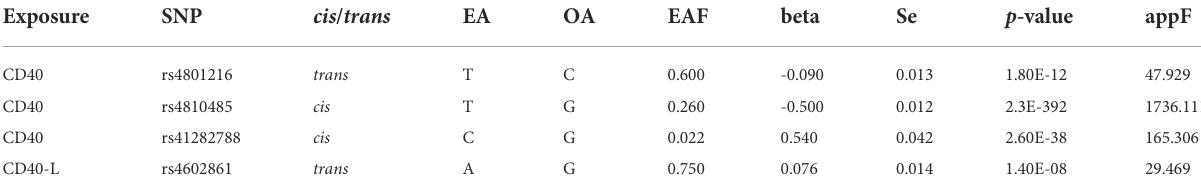
TABLE 1 SNPs used as IVs for MR analyses.